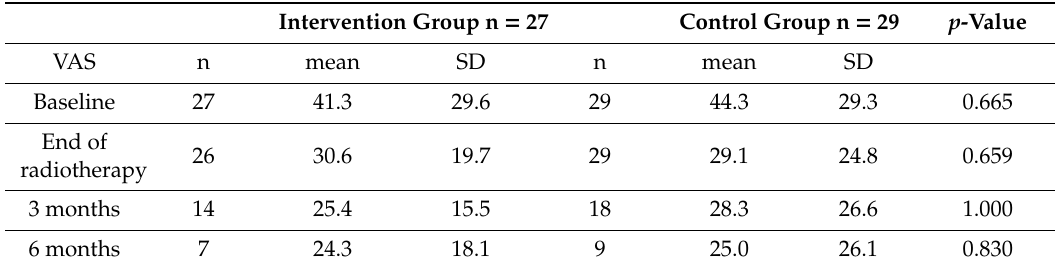
Table 2. Pain levels using the Visual Analogue Scale (VAS) at respective points in time of survey in both groups.